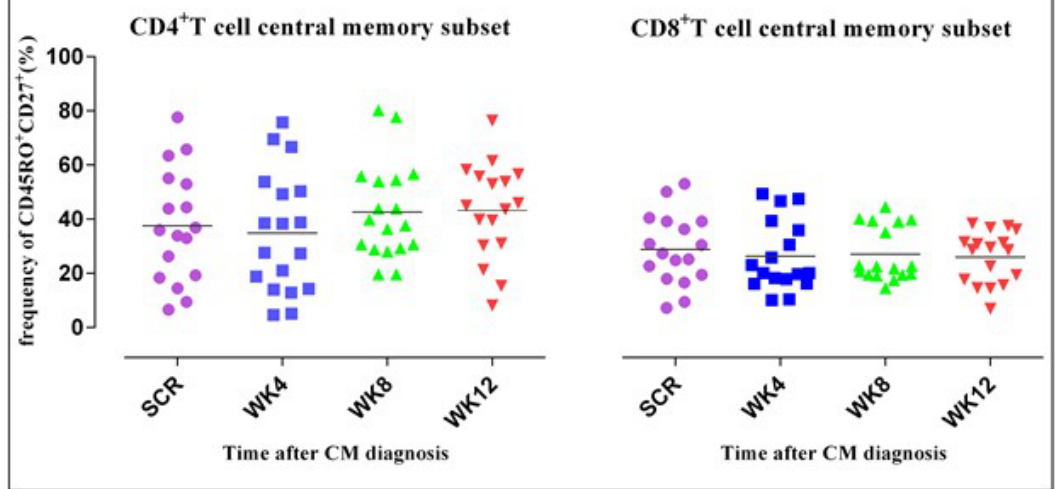
Figure 3. The CD4 + T CM subset frequency remained stable yet the CD8 + T CM subset declined.